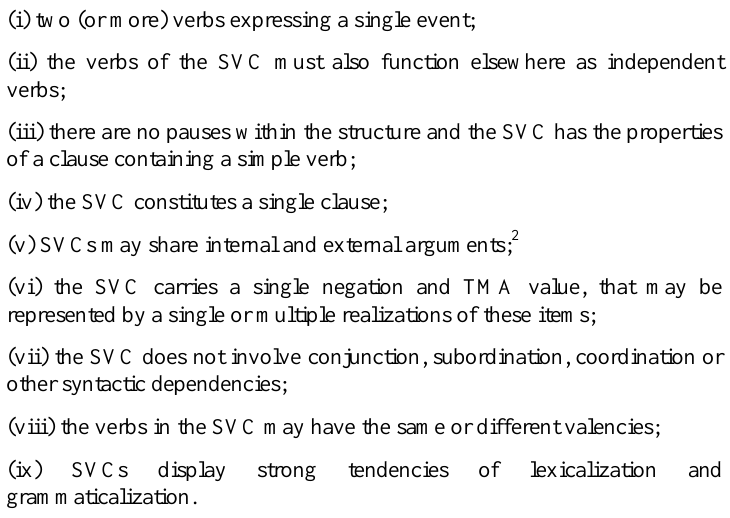
of lexicalization and